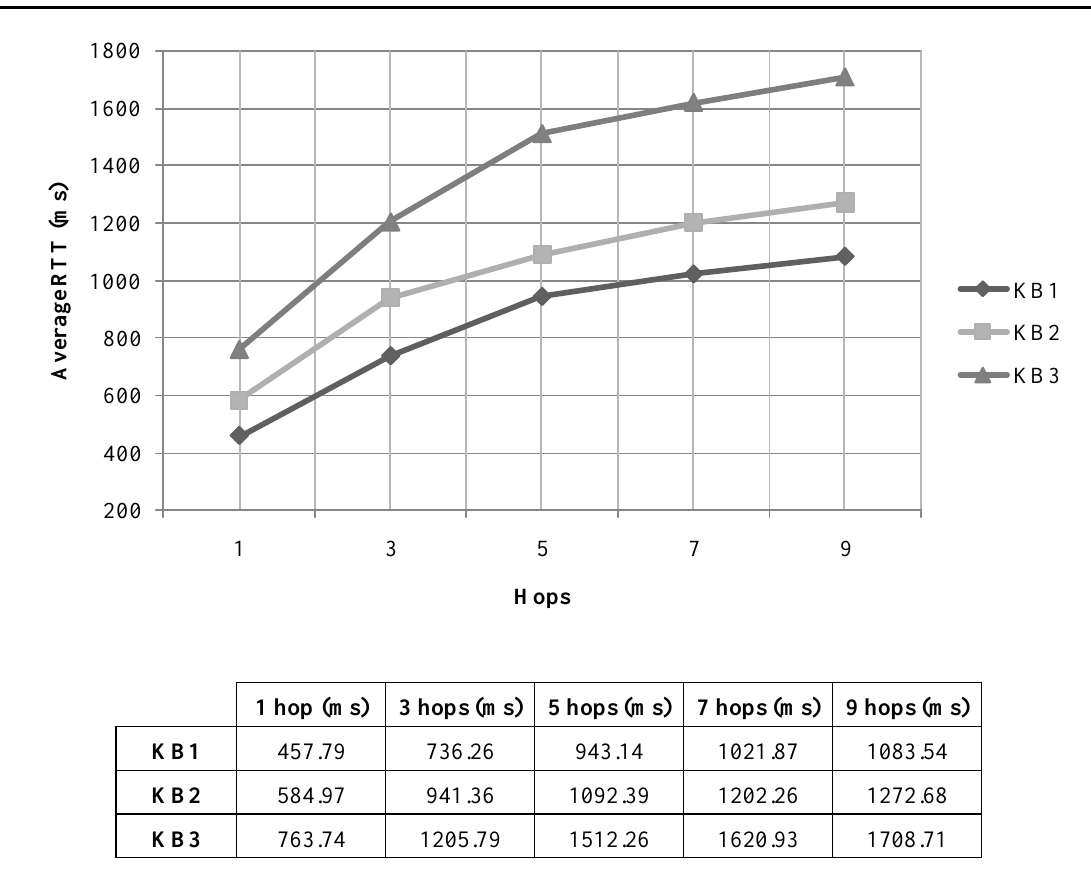
Figure 5. Average RTT values of the distribution of